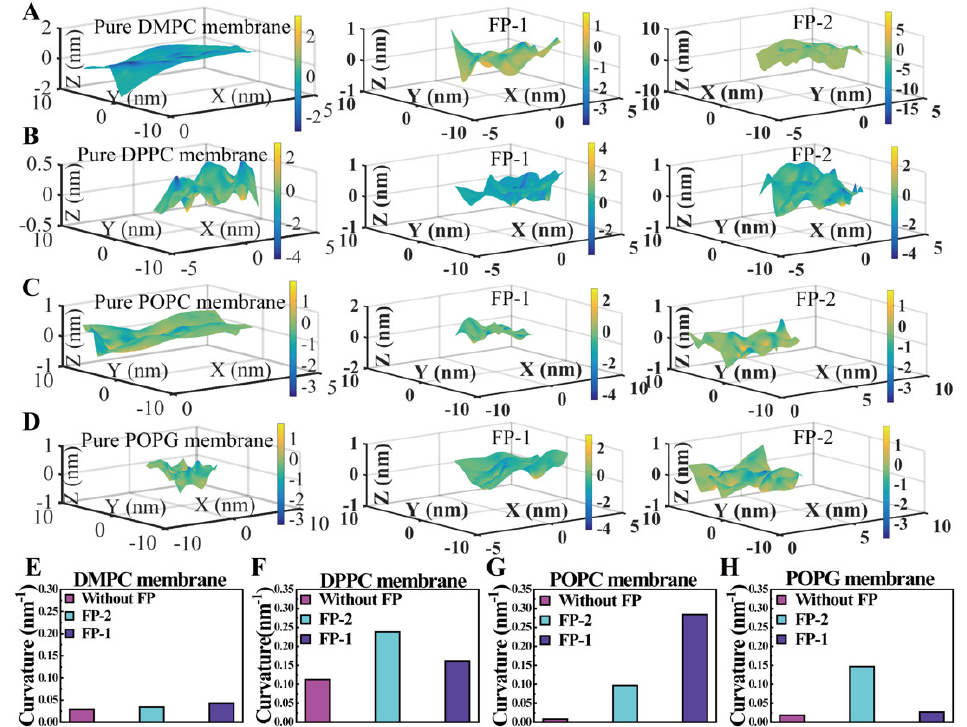
Figure 8. Analyses of the curvature of the lipid membrane at the end of simulation (t = 500 ns). ( A – D ) Three-dimensional surface of the upper layer of lipid membranes without and with two func- tional peptides. ( E – H ) Curvature of the upper layer of lipid membranes without and with functional peptides.